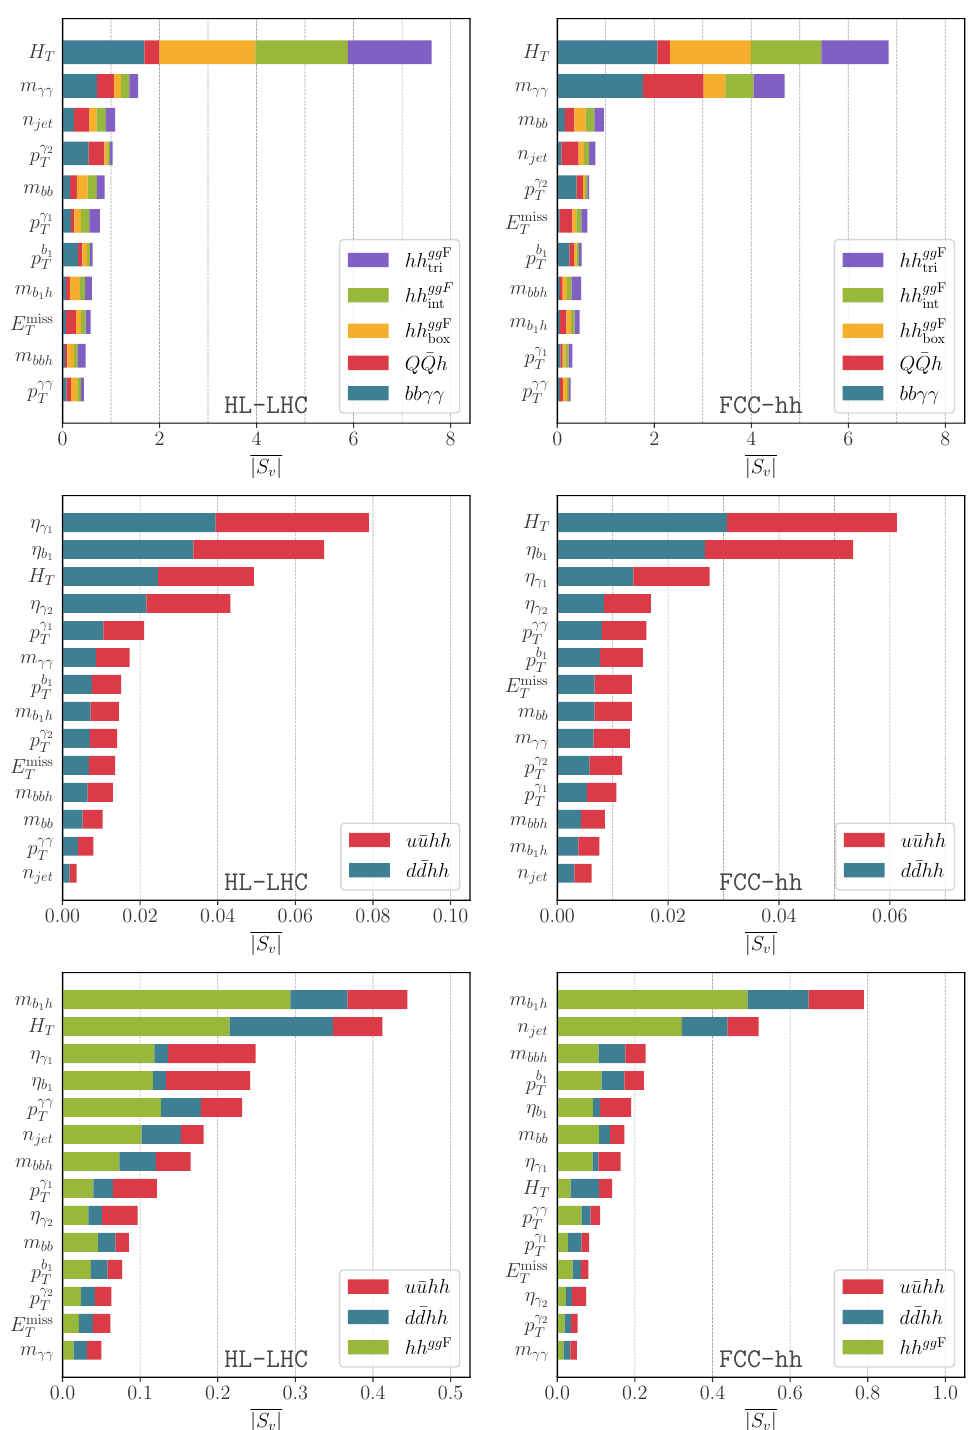
from hh gg F Figure 8 . Top panels: the hierarchy of variables important for the separation of hh gg F tri int events from hh gg F , Q ¯ Qh and b ¯ bγγ QCD-QED background at HL-LHC (left panel) and FCC-hh box (right panel). Middle panels: the hierarchy of variables important for the separation of u ¯ uhh from ¯ d dhh events at HL-LHC (left panel) and FCC-hh (right panel). Lower panels: the hierarchy of variables important for the separation of hh gg F , u ¯ uhh and d ¯ dhh events at HL-LHC (left panel) and FCC-hh (right panel). The higher the value of | S is, the more important the kinematic variable is v | in separating the different